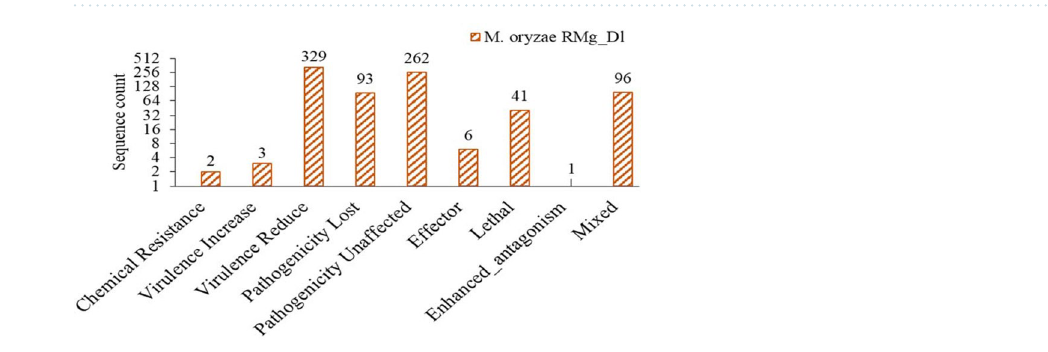
Figure 5. The assigned protein sequences to different PHI